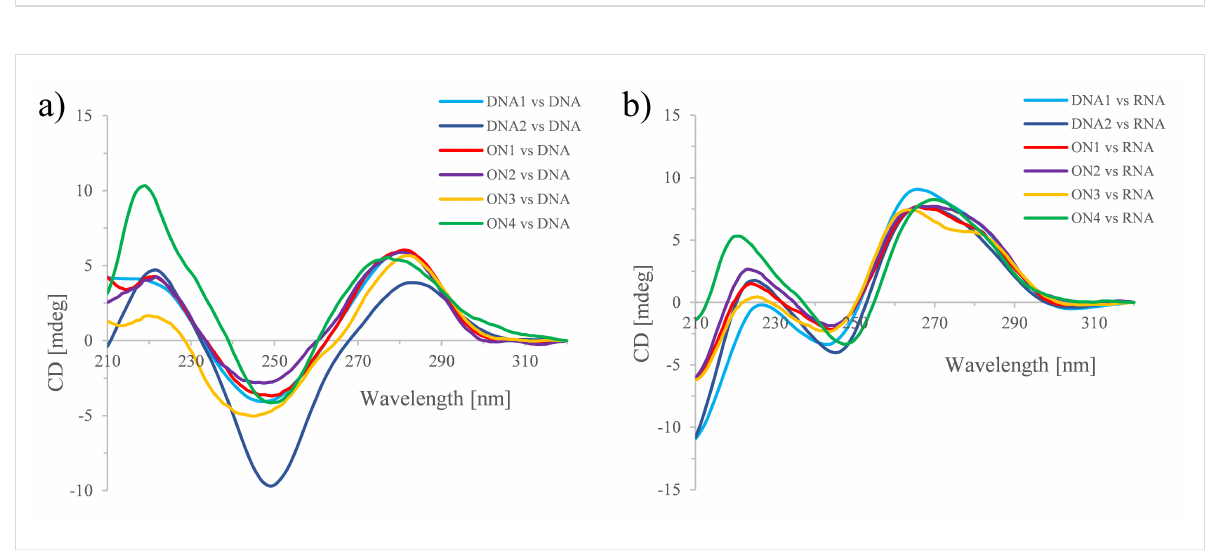
Figure 4: CD spectra of ON1 – 4 with complementary a) DNA, and b) RNA. Total strand conc. 2 μ M in 10 mM NaH 2 PO 4 , 150 mM NaCl, pH 7.0.